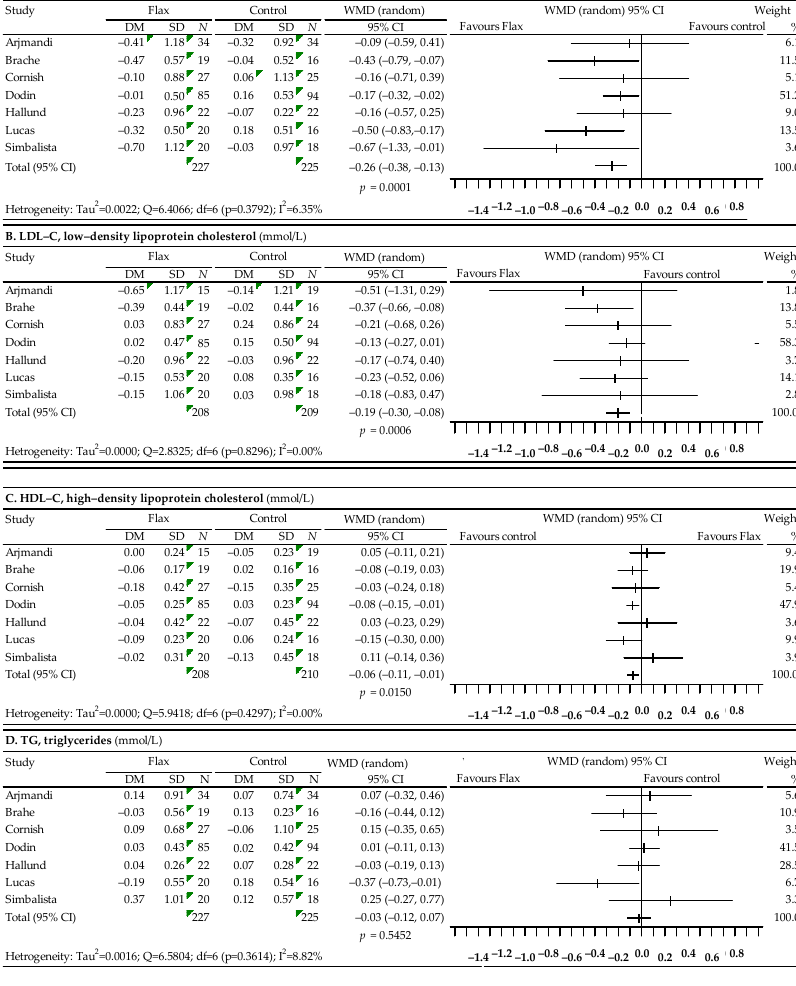
Figure 2. Forest plot representing the associations between flaxseed and lipid profiles. Data are pre- sented as weighted mean difference with 95% CI.